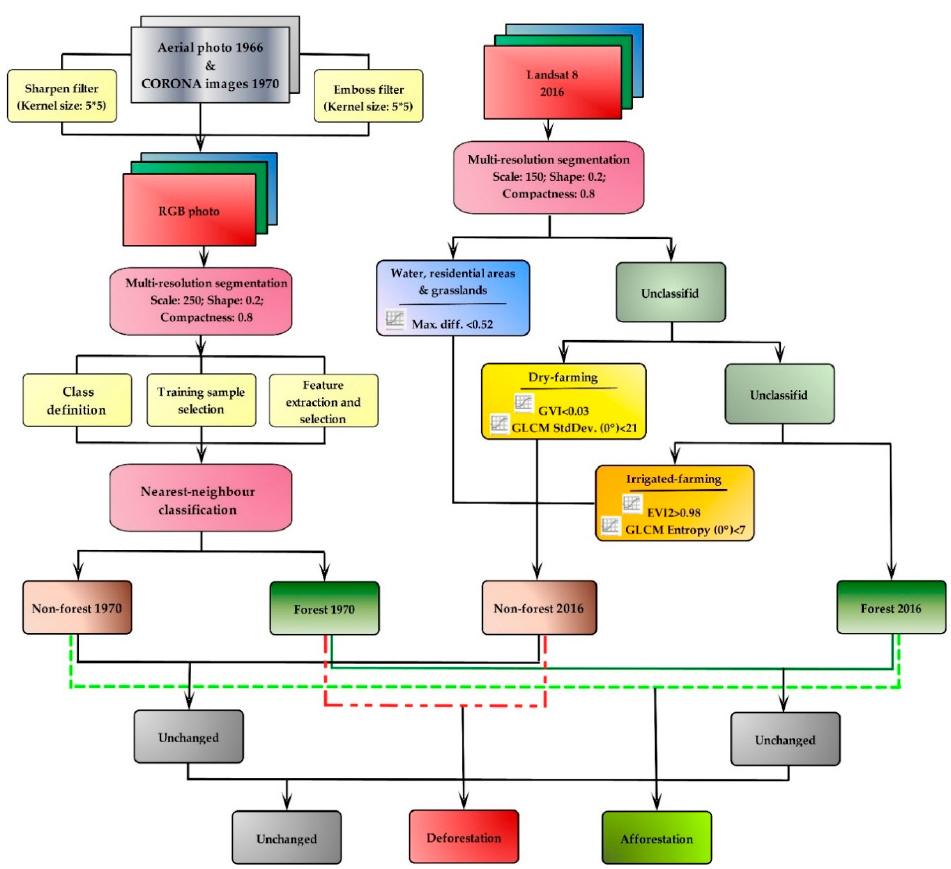
Figure 2. The process of discriminating forests from non-forests using object-based nearest neighbor and rule-based classifications by utilizing CORONA images/aerial photos of 1970 and Landsat 8 of 2016 over the protected and non-protected forests in NE, Iran (after Shirvani et al. [82]). Abbreviations: stdDev.: Standard deviation; Max. diff.: Maximum difference; GVI: Green Vegetation Index; EVI2: Enhanced vegetation index2; GLCM: Gray-level co-occurrence matrix.